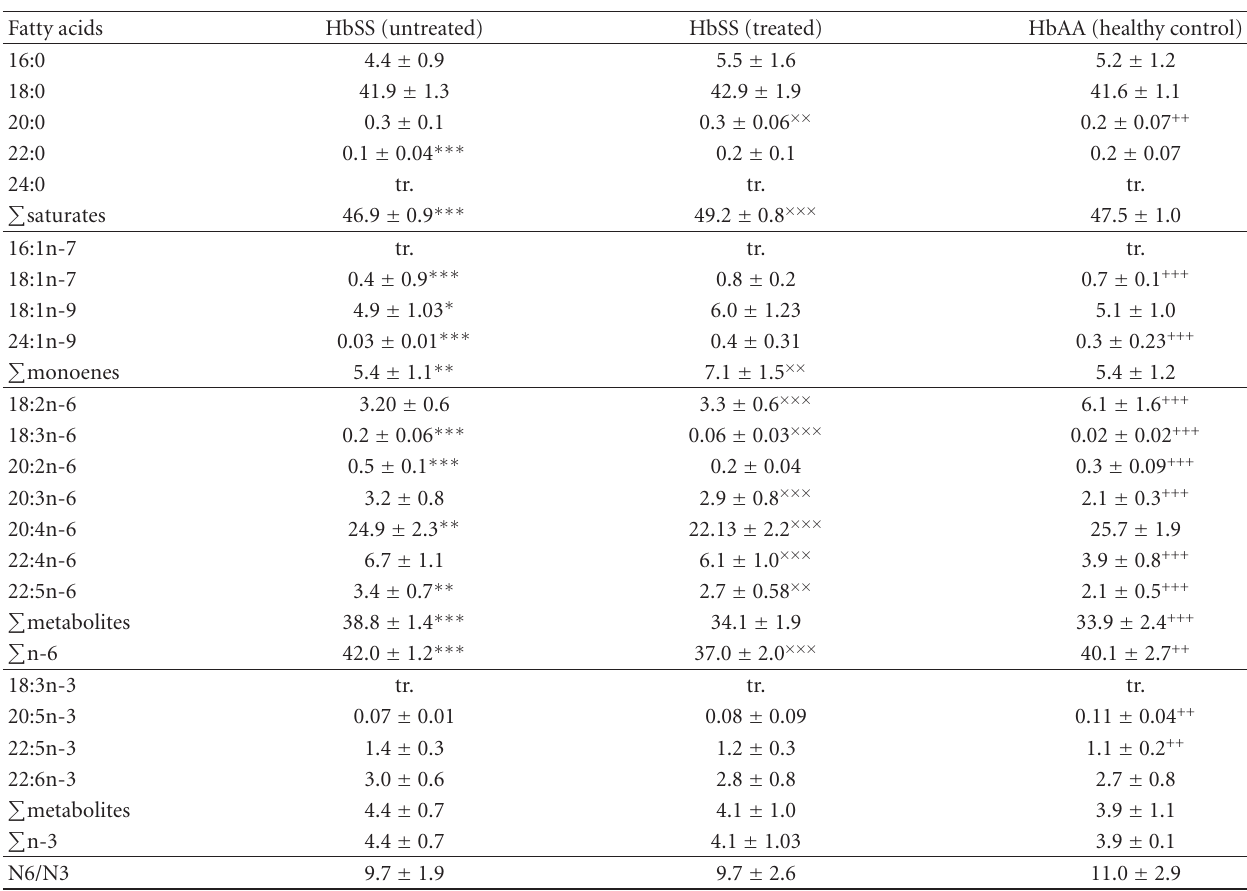
Table 6: Fatty acid composition of red blood cell serine phosphoglycerides of HU-untreated ( n = 17) and treated ( n = 19) HbSS sickle cell patients and HbAA healthy controls ( n =